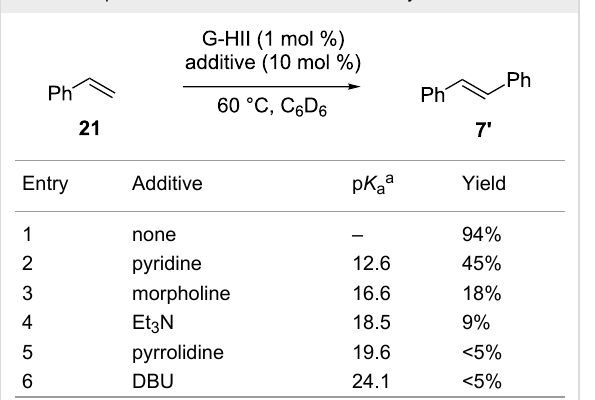
Table 2: Impact of amino additives on the CM of